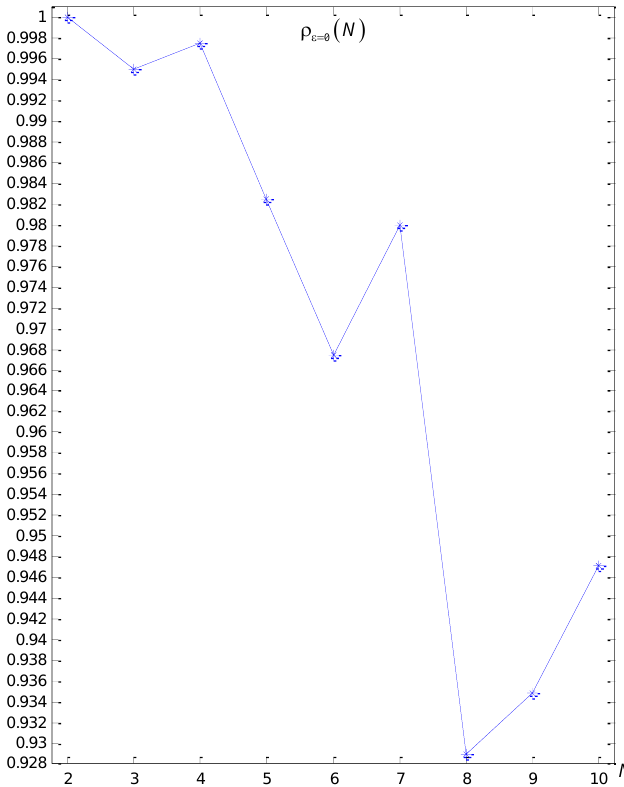
Fig. 7. The ratio of non-timeout instances, in which the heuristic gives the minimal TWT, to the total number of non-timeout instances. It is strictly 1 in scheduling just 2 jobs, independent of the number of processing periods they are divided. The ratio is decreasing till 8 jobs. The minimum of the ratio is at 8 jobs, where 92.89 % of the non-timeout instances have been scheduled by the heuristic as optimally as the BLPM has scheduled them. Thus, the heuristic can efficiently substitute the BLPM at least in 92.89 % of the cases.